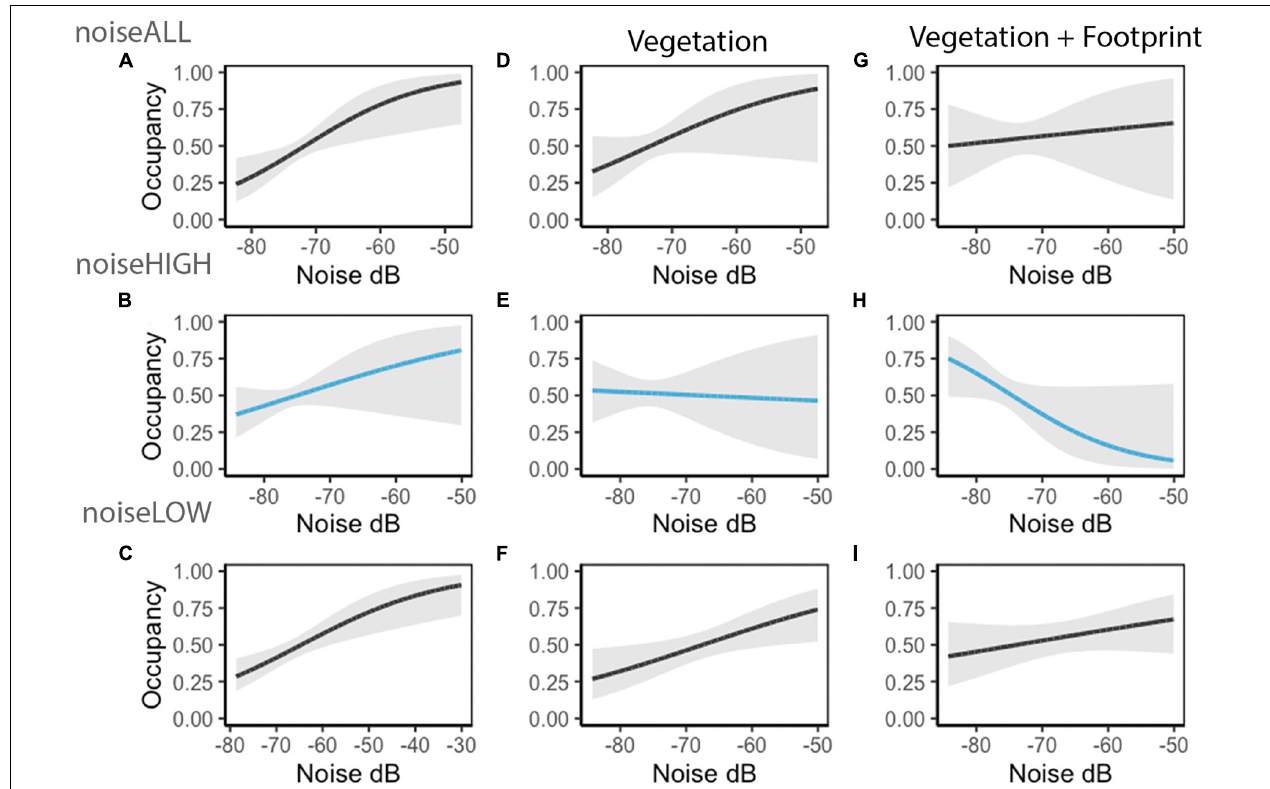
FIGURE 8 | Lincoln’s Sparrow occupancy predicted values (95% CI, gray shade) changed with each noise metric. Each row represents three set of models: noise as unique predictor, and when additional variables are included (e.g., noiseALL, noiseALL + vegetation, and noiseALL + vegetation + proportion of footprint). Each row shows how Lincoln’s Sparrow occupancy estimates varied by noiseALL (A,D,G) , noiseHIGH (B,E,H) , and noiseLOW (C,F,I) .